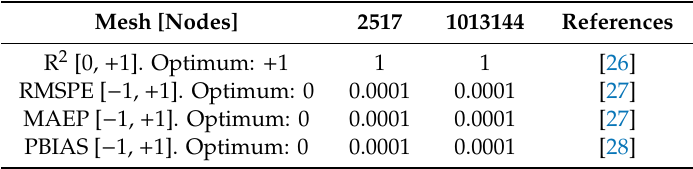
Table 2. Metrics for the validation of FEMM vs. analytical solution. from the contrast of both results (the FEMM and studied model), we obtained the proposed metrics. R 2 —coefficient of determination; RMSPE—root mean square percentage error; MAEP—mean absolute percentage error; PBIAS—percentage